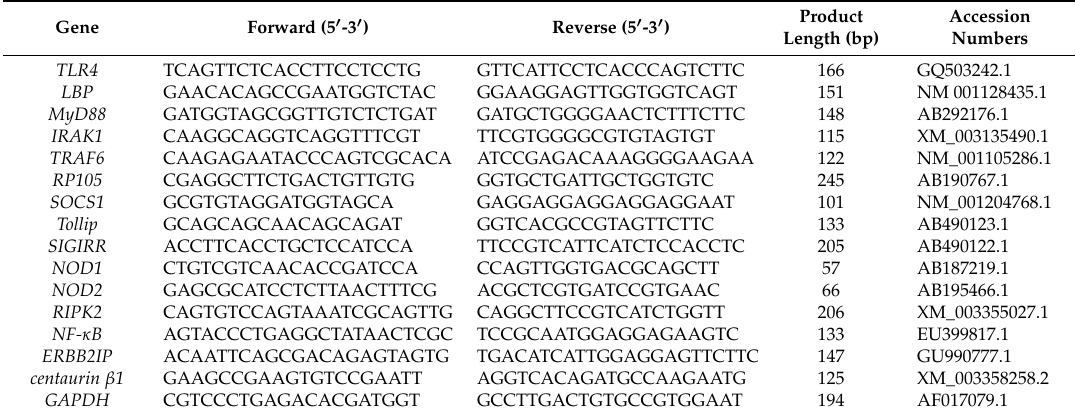
Table 8. Primer sequences used for real-time